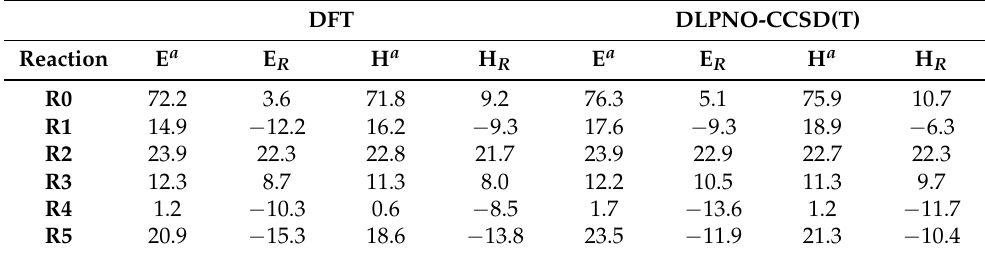
1 Energy and enthalpy values (kcal/mol) from the end points of IRC and relative to the reactants of the corre- sponding reaction.